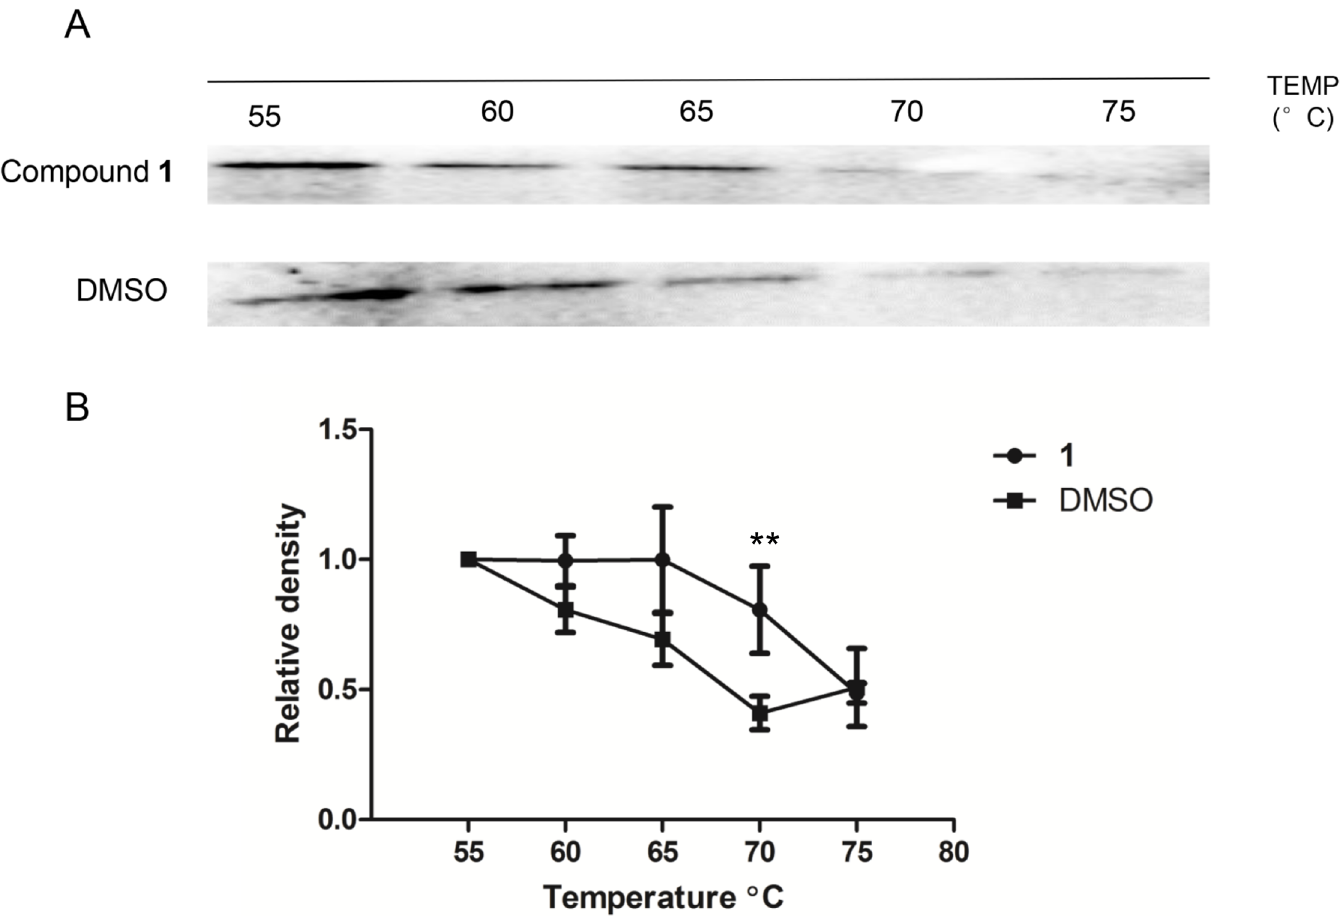
Fig 4. Compound 1 stabilizes JAK2 in A375 cells. (A) Stabilizationof JAK2 by 1 . (B) The band intensity of JAK2 with different temperatures. The data were normalized to the JAK2 level of control group at 55˚C and are expressedas the means ± SD of three individualexperiments. The data were analyzed using Image Lab. Error bars represent the standarddeviationof triplicate results. Significantdifferences versus control at the same temperature are indicated by ** p < 0.01.